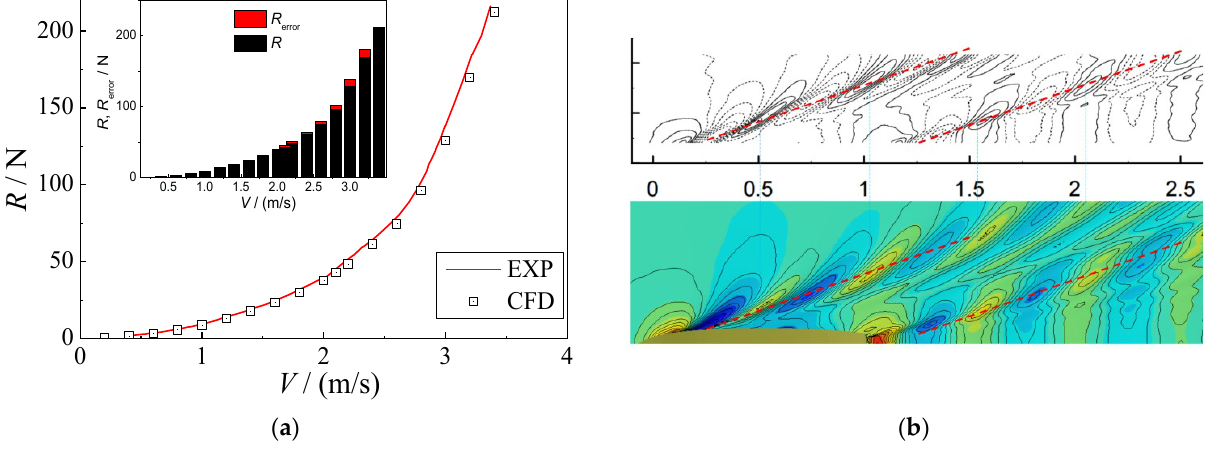
Figure 5. Comparison between DTMB5415 experimental results [53] and CFD results. ( a ) Resistance of DTMB5415 ship model. ( b ) Wave elevation contours of DTMB5415 ship model at Fr = 0.28.